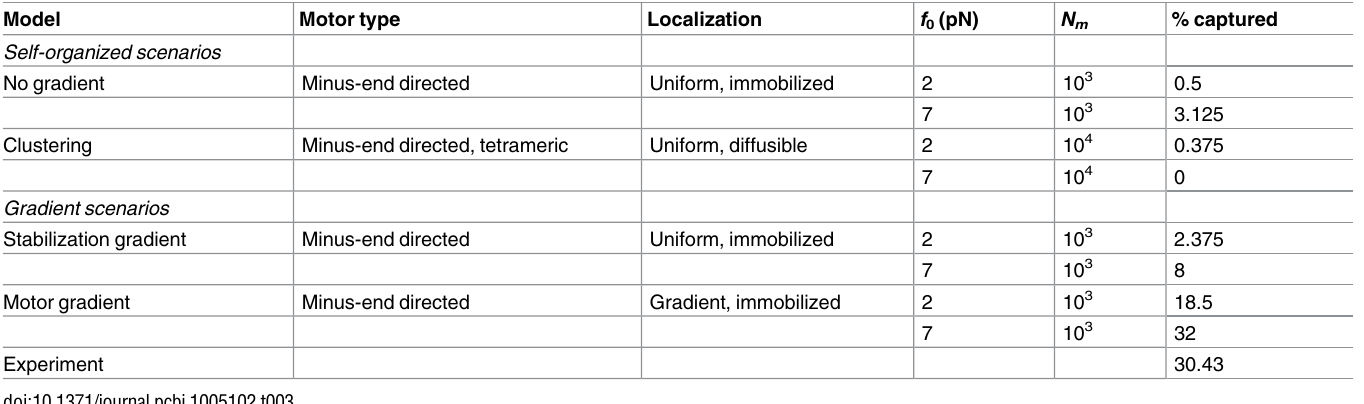
Table 3. Percentage of MTOCs captured. After 20 min simulation time the proportion of MTOCs captured were evaluated for the different scenarios in the mechanistic models and compared to experimental values on a similar time-scale. Values are estimated from 10 runs of a typical simulation with 80 MTOCs